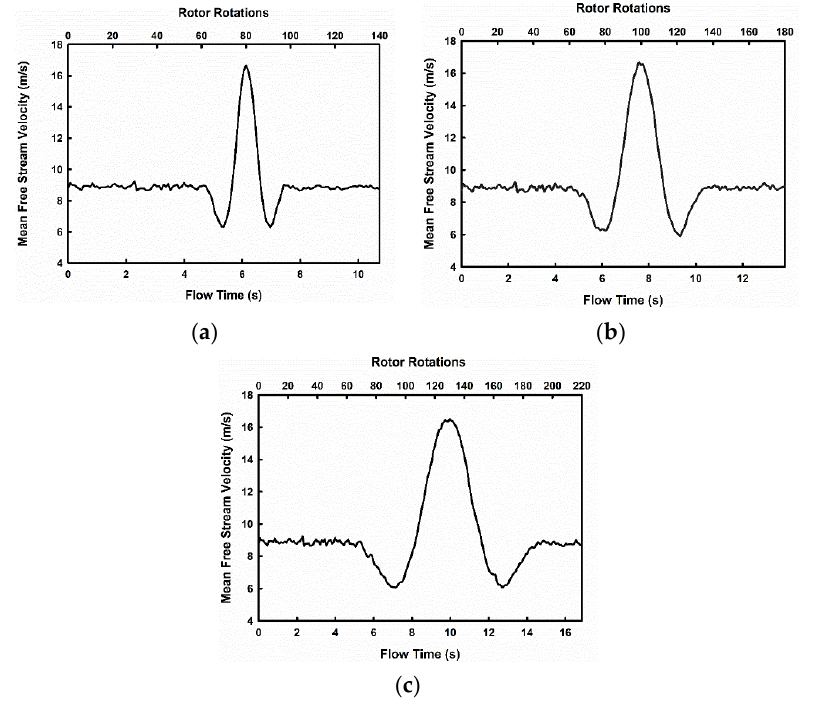
Figure 21. The variation of cycle-averaged mean free stream velocity (U∞) for gust time periods ( a ) 3 s; ( b ) 6 s; ( c ) 10.5 s.